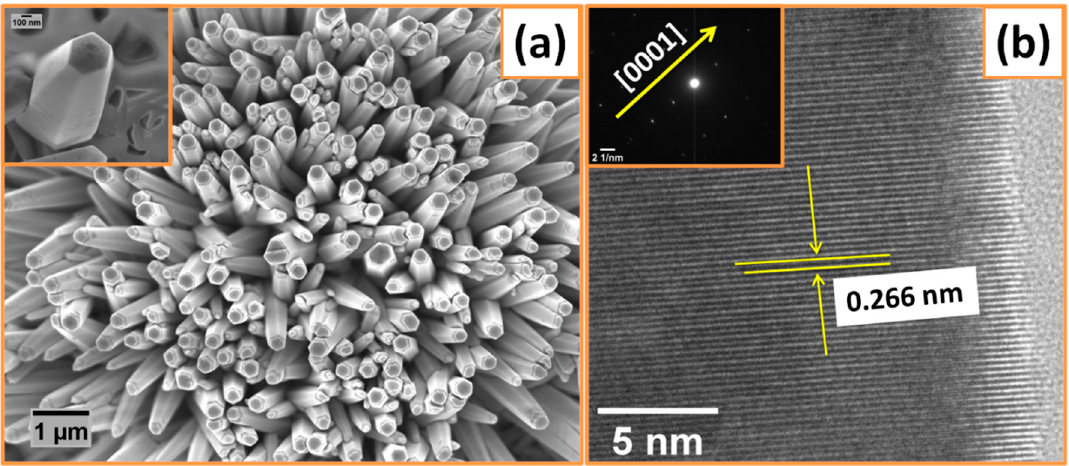
Figure 3. ( a ) Field-emission scanning electron microscope (FE-SEM) image of ZnO nanorods, inset shows a single nanorod. ( b ) HRTEM image, and inset shows the SAED pattern of ZnO nanorods.